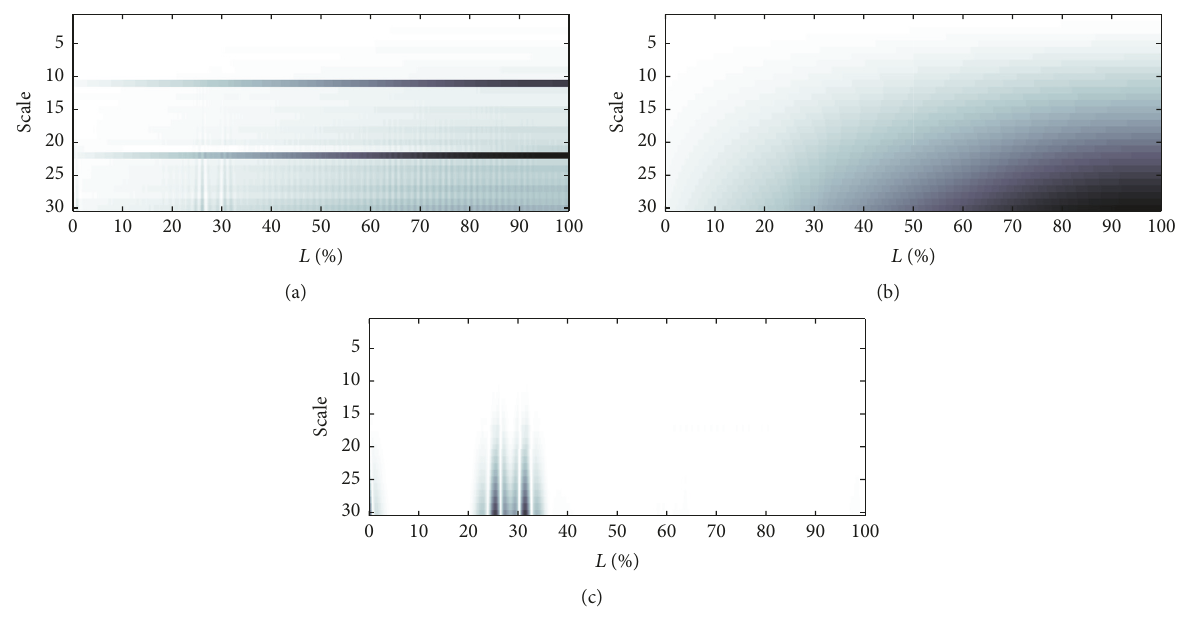
Figure 12: Typical scalograms obtained using different wavelet functions: (a) Morlet; (b) Haar; (c)